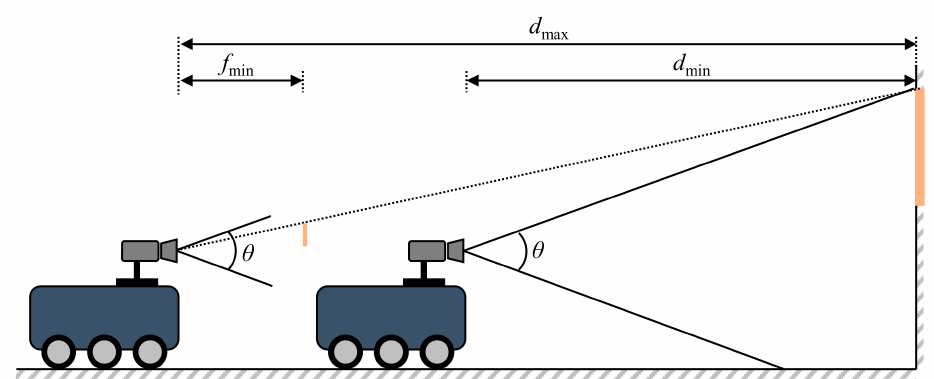
Figure 9. Maximum and minimum recognition distances.